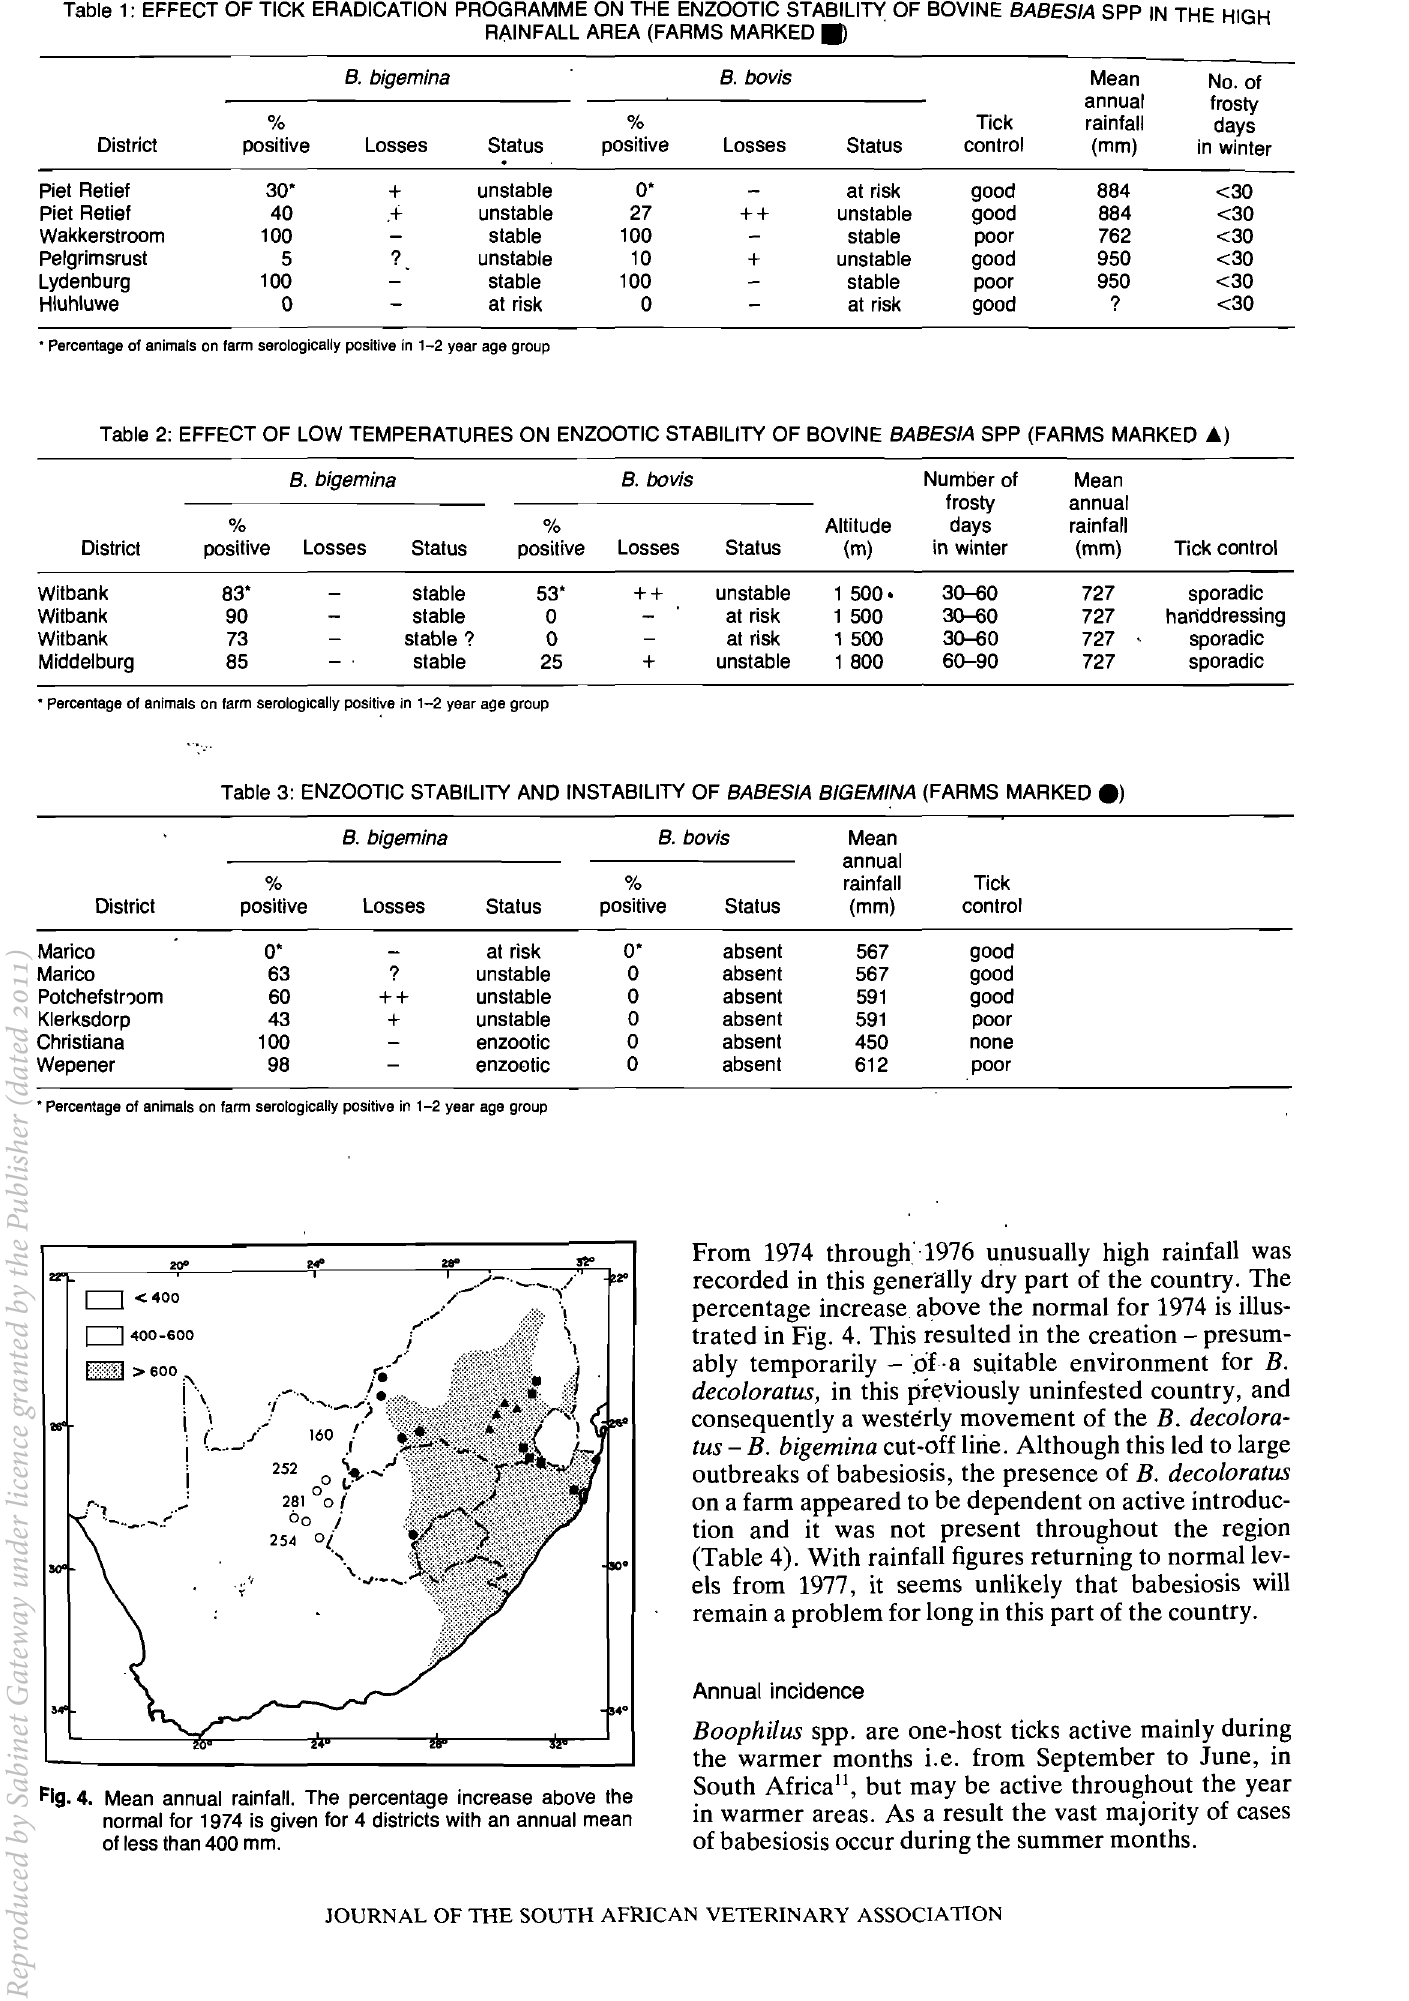
Table 1: EFFECT OF TICK ERADICATION PROGRAMME ON THE ENZOOTIC STABILITY OF BOVINE BABESIA SPP IN THE HIGH RAINFALL AREA (FARMS MARKED.